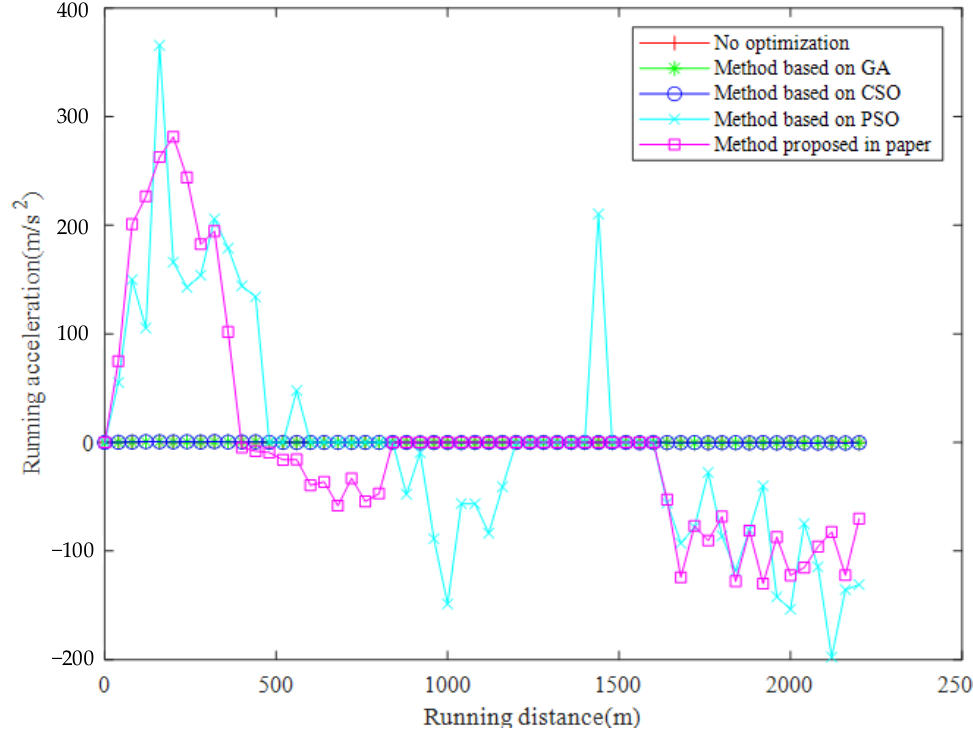
Sensors 2023 , 23 , 378